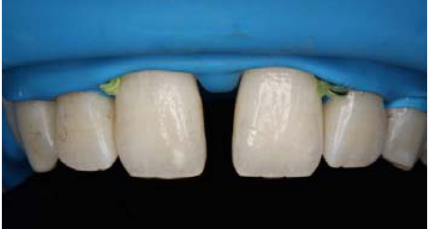
Figure 3: Maxillary anterior teeth were isolated with rubber dam and the central incisors were retracted with retraction cord. No preparations were achieved.